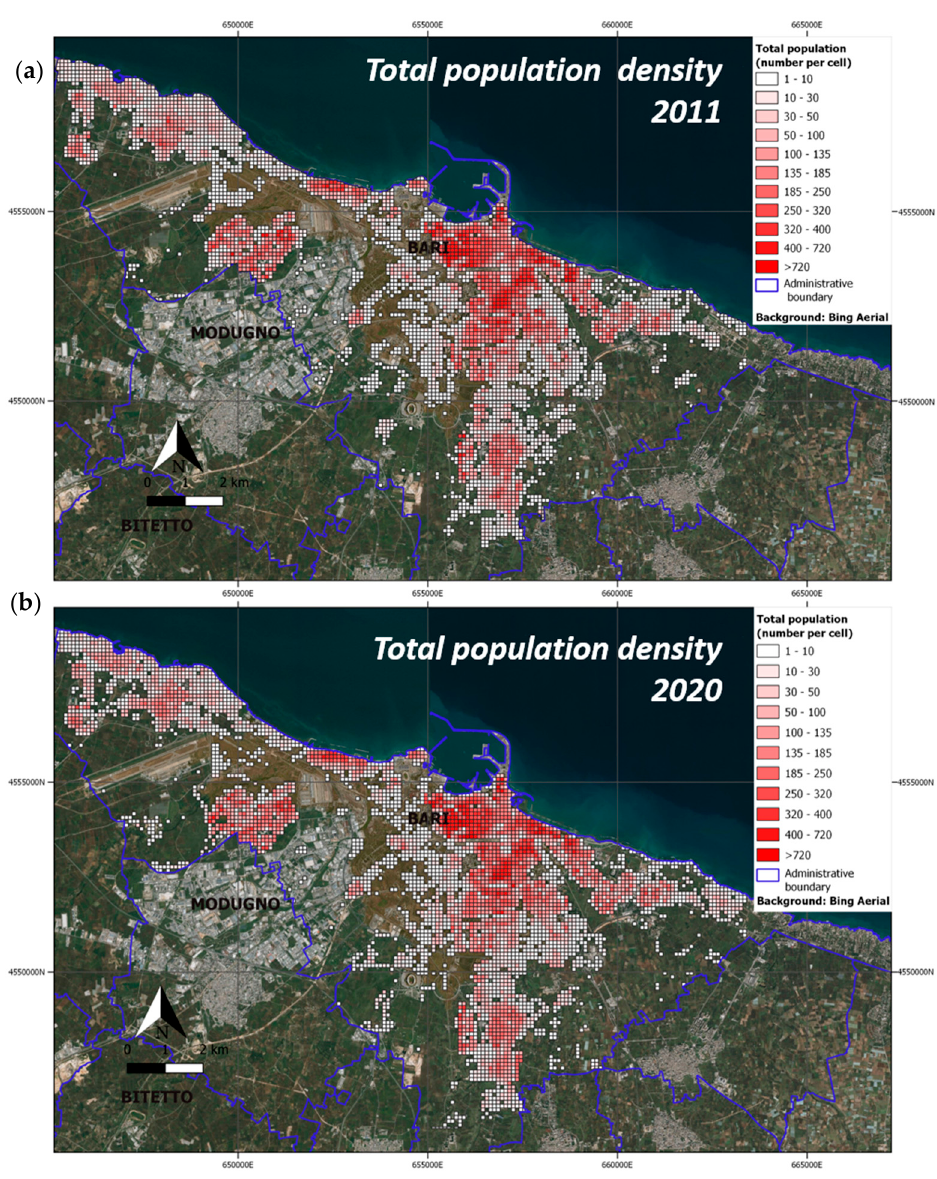
Figure 14. Grid population density map for the total population in 2011 ( a ) and 2020 ( b ). For comparison, the classes in the choropleth representation [37] are the same in all images shown.